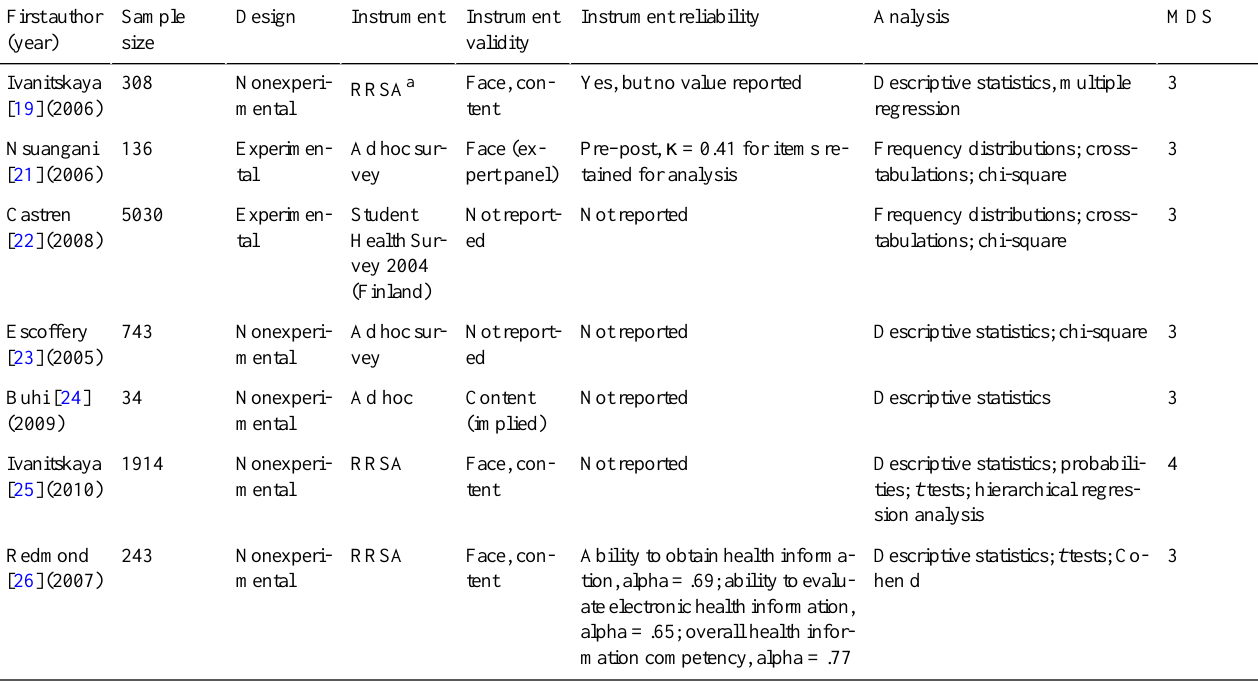
Table 2. Design, measurement, analysis, and methodological data score (MDS) of selected